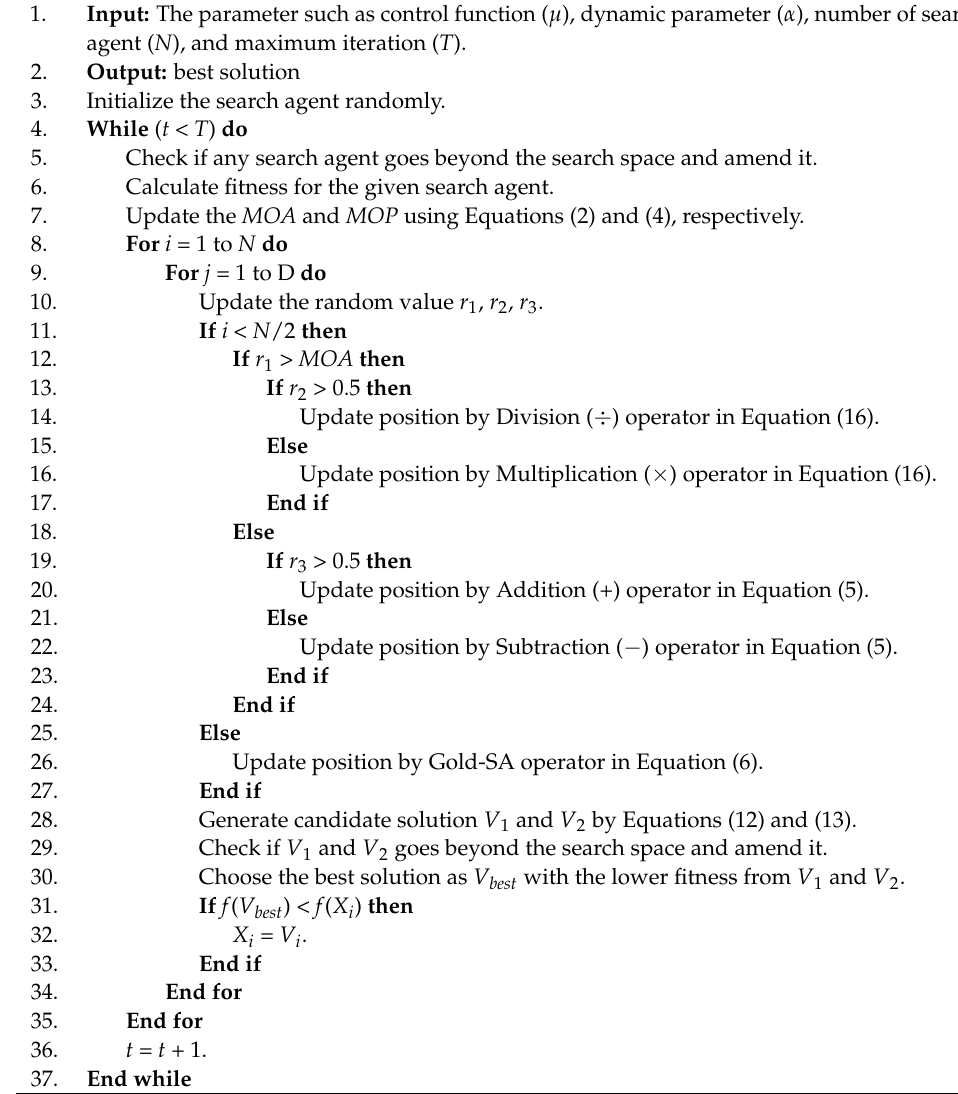
Algorithm 3 pseudo-code of